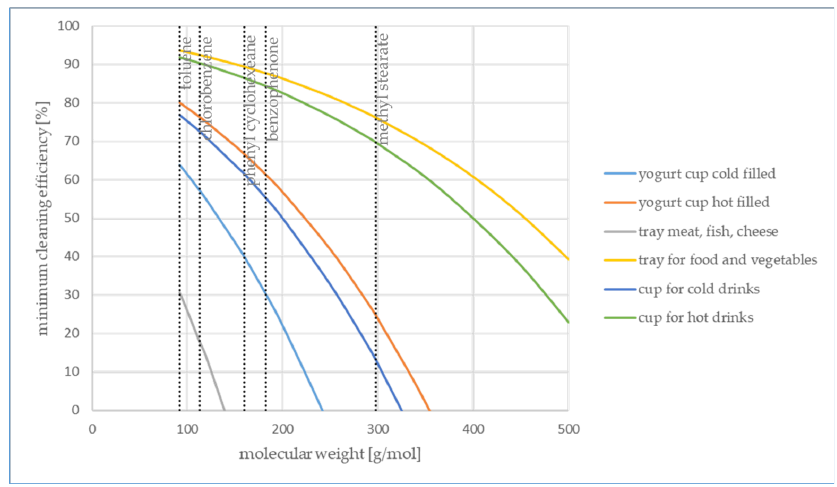
Figure 2. Minimum cleaning efficiencies for the applications given in Table 4 calculated with an OEF of 5 of the A P ’ Model. Table 4. Minimum cleaning efficiencies for the super-clean recycling process for the applications given in Table 2 (over-estimative for the calculation is factor of 5 as applied by EFSA for low diffu- sive polymers).